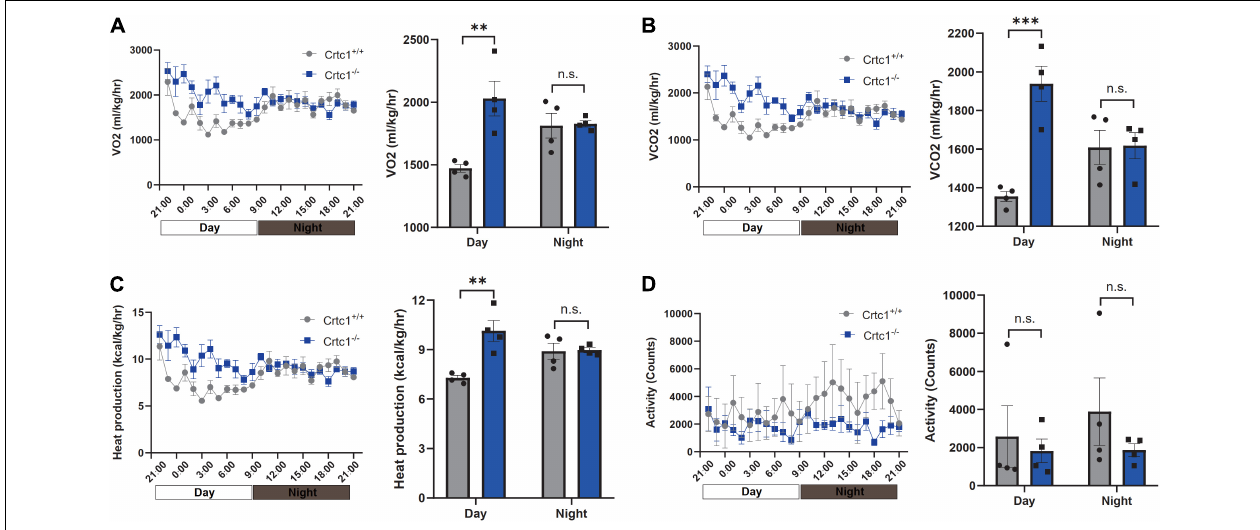
FIGURE 3 | Effect of Crtc1 on indirect calorimetry. (A) O 2 consumption curve and average O 2 consumption. (B) CO 2 production curve and average CO 2 production. (C) Heat production curve and average heat production. (D) Activities counts curve and activities counts, measured over 24 h in Crtc1 + / + and Crtc1 − / − mice at the age of 6 months. Data are mean ± SEM; ** P < 0.01, *** P < 0.001 and n.s. indicates no significant difference.